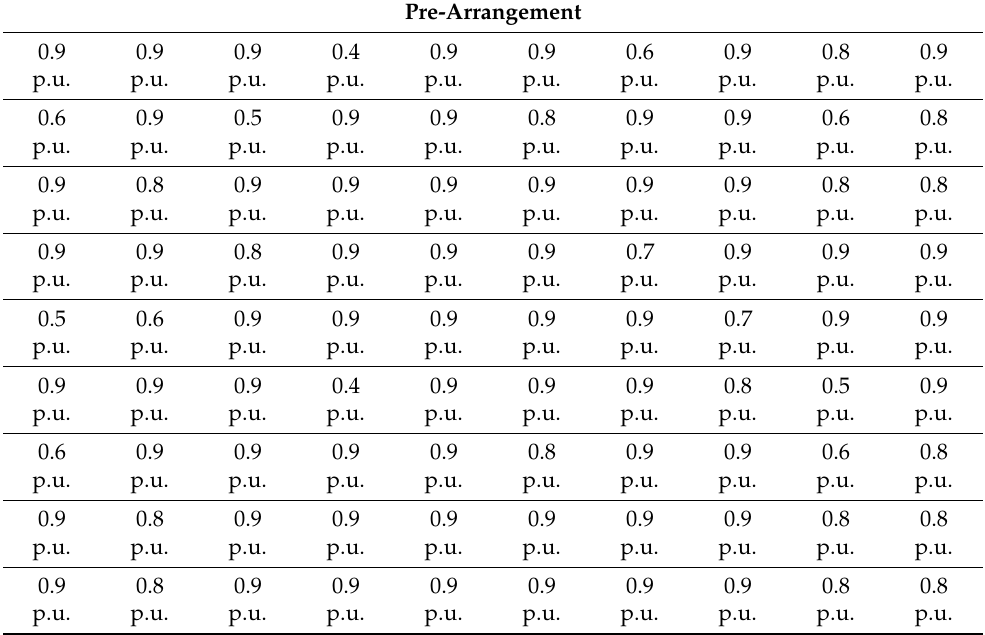
Table 10. The parameters associated with the two types of 10 × 10 PV arrays (i.e., 18-kW and 43-kW) after application of reconfiguration in 14 different